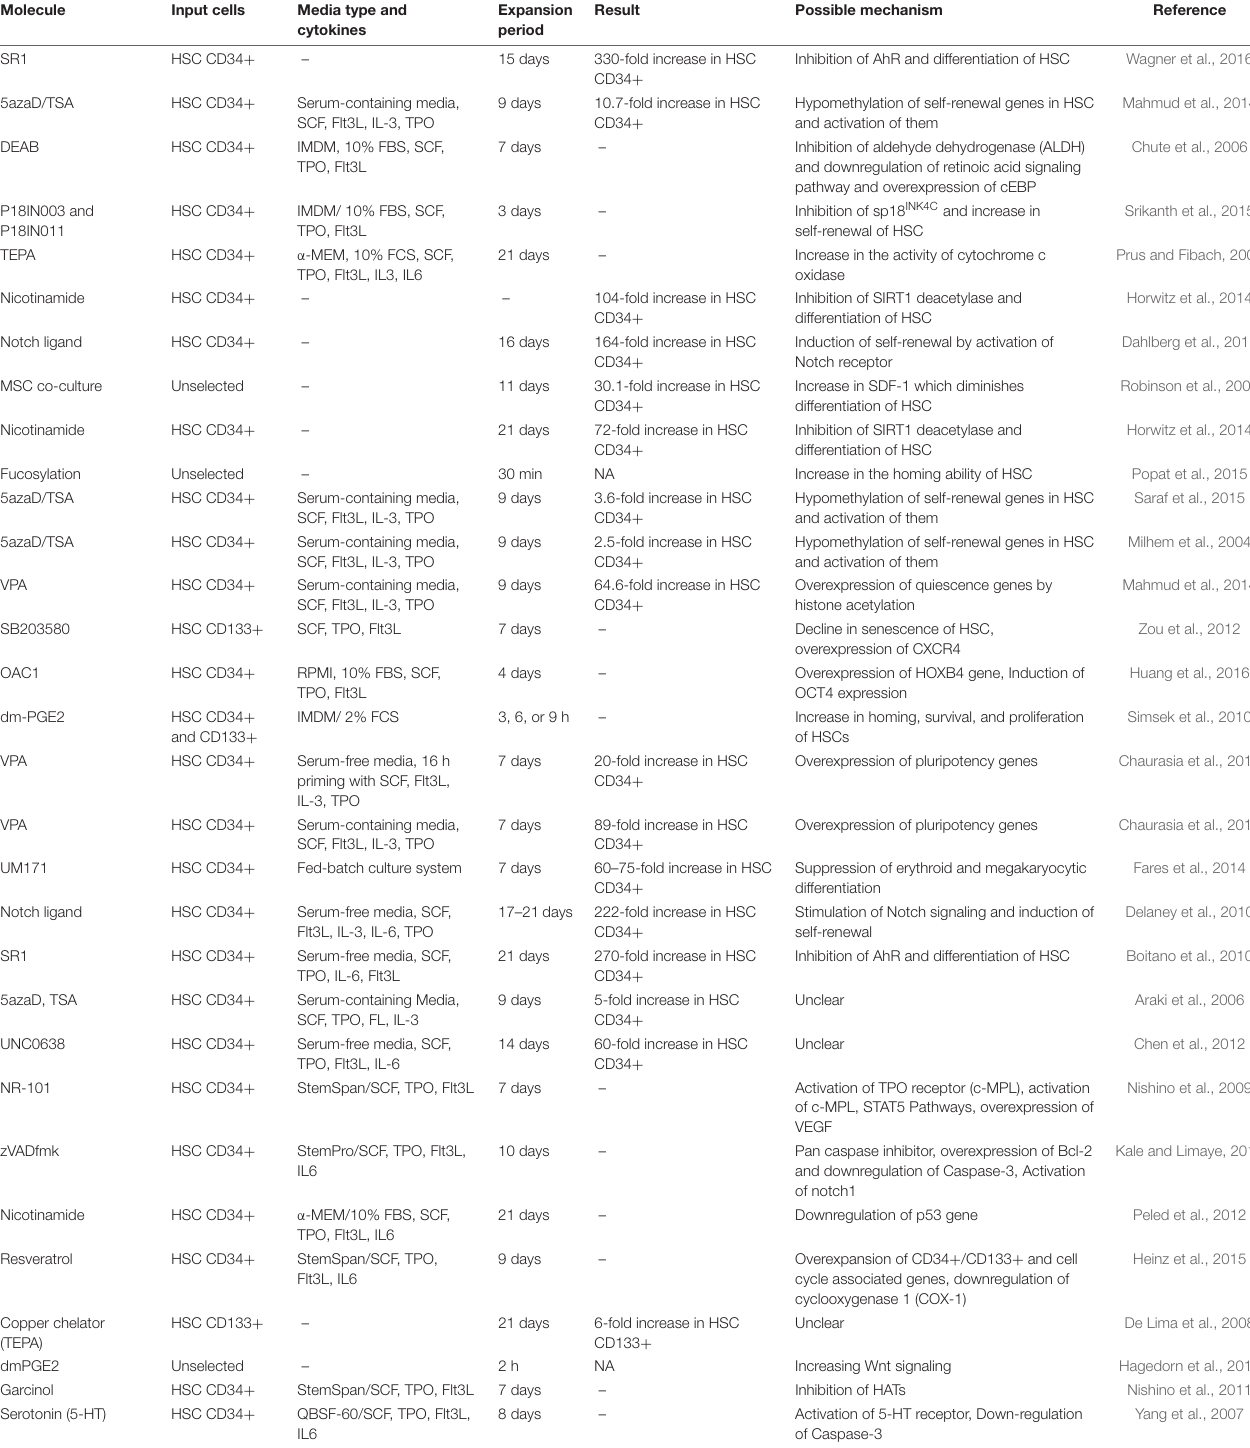
TABLE 1 | Effects of small molecules on ex vivo expansion of cord blood hematopoietic stem cells.